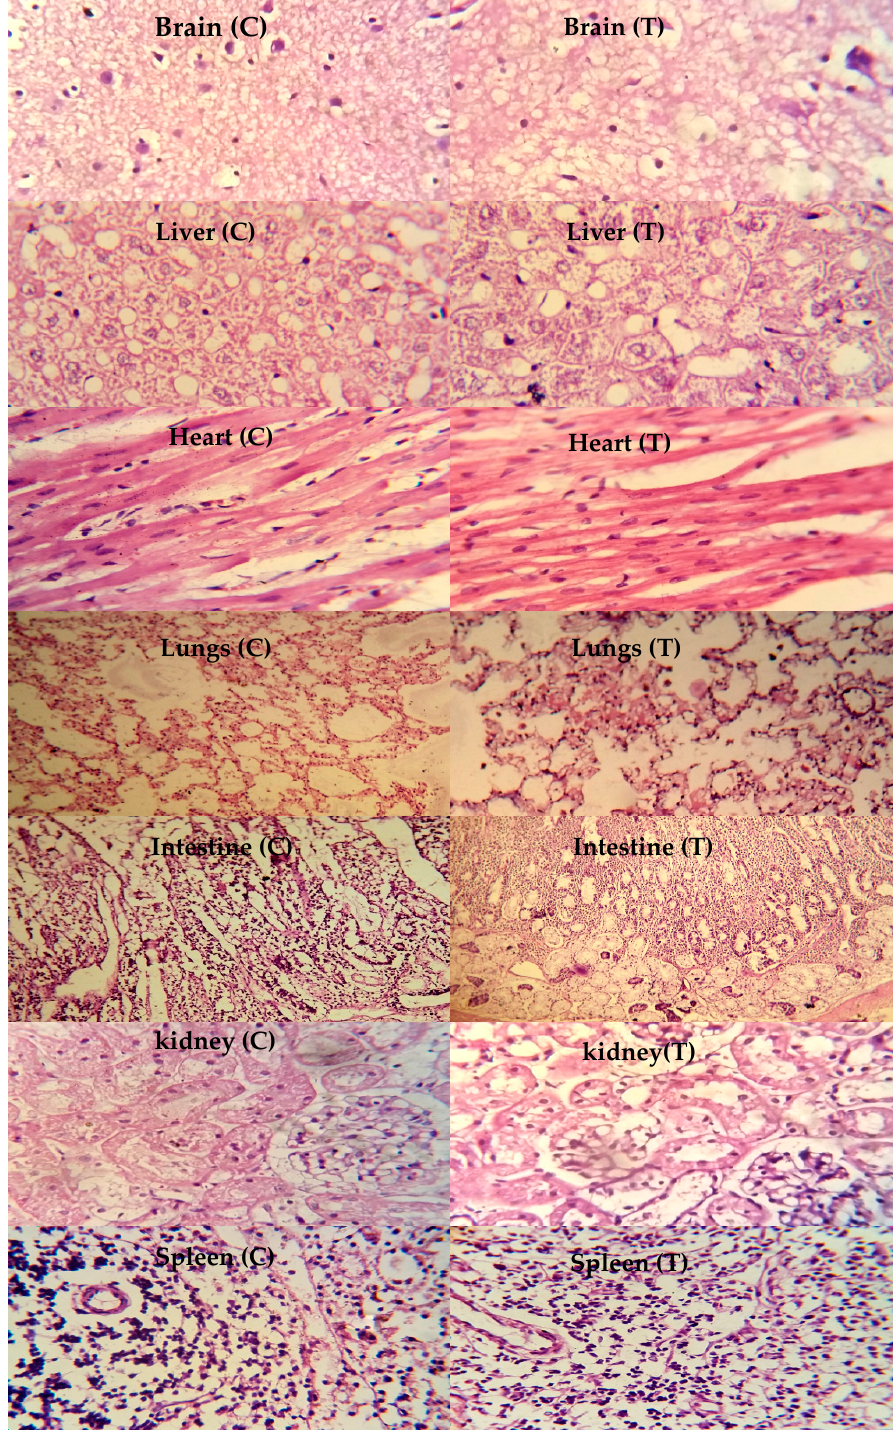
Figure 11. Histopathological examination of rabbit’s vital organs, C: control group and T: treated group, magnification ×40.